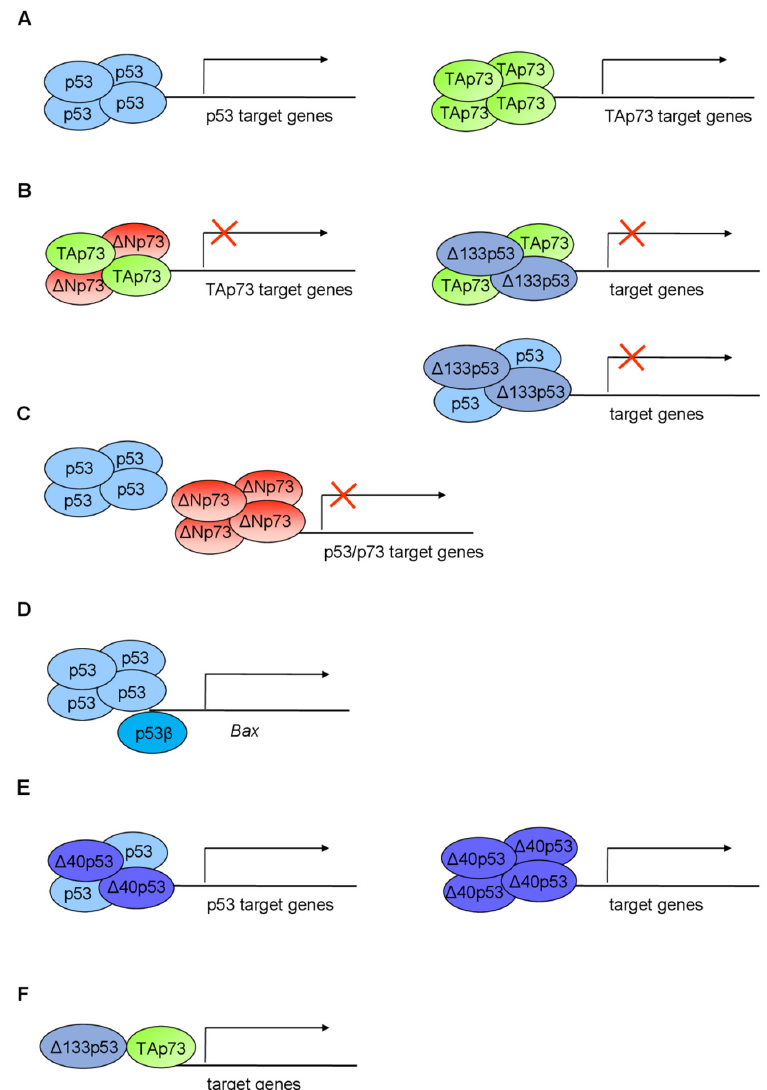
Figure 5. Schematic overview of the p53/p73 isoform interactions mediating transactivation. ( A ) The p53/p73 isoforms form homotetramers to transactivate target genes; ( B ) certain p53/p73 isoforms can form heterotetramers and consequently antagonize p53/TAp73 transactivation ability or ( C ) compete with p53/TAp73 for the same promoter sequences, thus exerting a dominant-negative effect; ( D ) p53 β can modulate the promoter activity of target genes (e.g., BAX ) only in the presence of p53 α ; ( E ) the p53 isoforms can independently mediate transactivation; ( F ) the p53 isoforms cooperate with the other family members, e.g., p73, to mediate transactivation. Adapted from Anbarasan p73: Friend or foe in tumorigenesis. Nat. Rev. Cancer 2002, 2, 605–615, doi: 10.1038/nrc861. (should be added to the references).